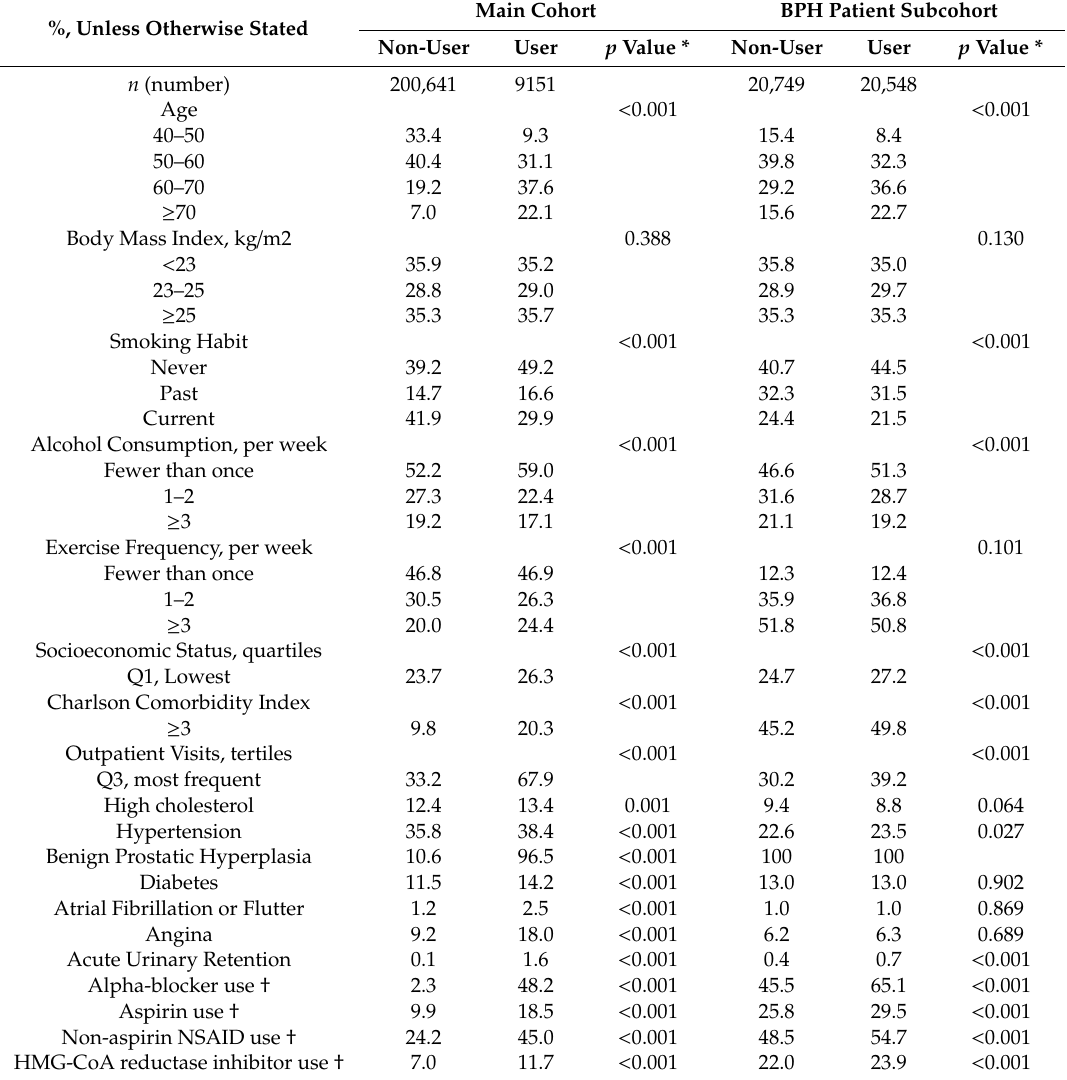
Table 1. Characteristics of the Main Cohort and BPH patient subcohort by 5ARI